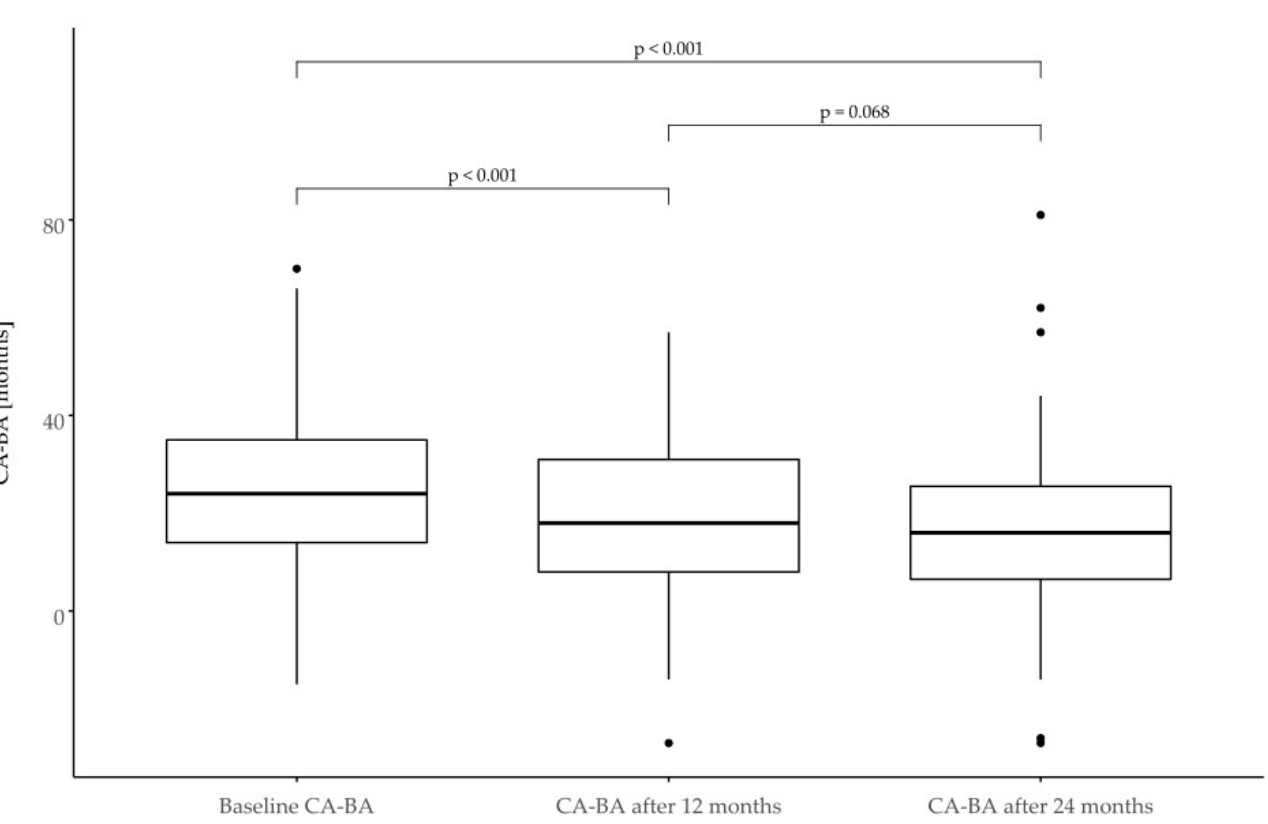
Figure 5. Difference in calendar age and bone age (CA-BA) in SGA children expressed in months at the baseline and after 12 and 24 months of treatment.